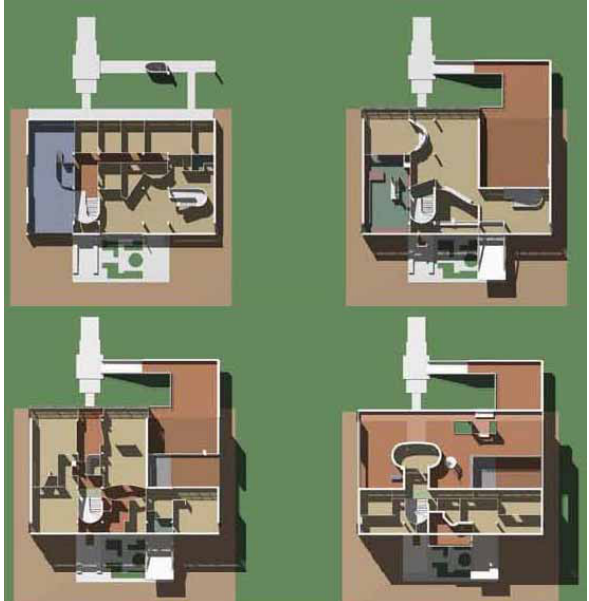
Figure 9. Villa Stein by Le Corbusier. Two-dimensional